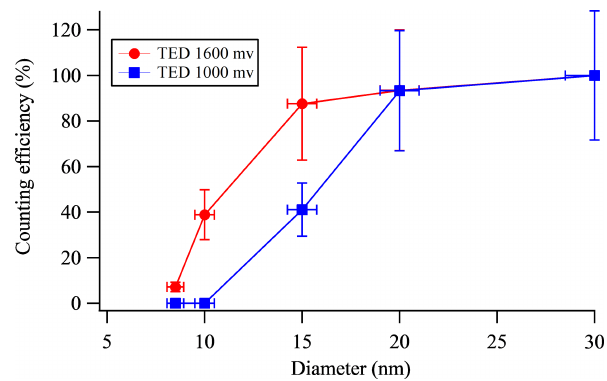
Figure 1. Counting efficiency as a function of particle diameter is shown for two TSI 3007 CPCs. Thermal electric devices (TEDs) of the two CPCs were set at 1000 and 1600mV, respectively. The counting efficiencies were calculated relative to counts with ther- mal electric device set at 2000mV for atomized ammonium sul- fate particles. Uncertainty in diameter is ± 5%, estimated from the uncertainties in the voltage and flow conditions in the DMA used for calibration. Uncertainty in ratio is ± 28%, and is calculated us- ing the published concentration accuracy of the model 3007 CPCs ( ±